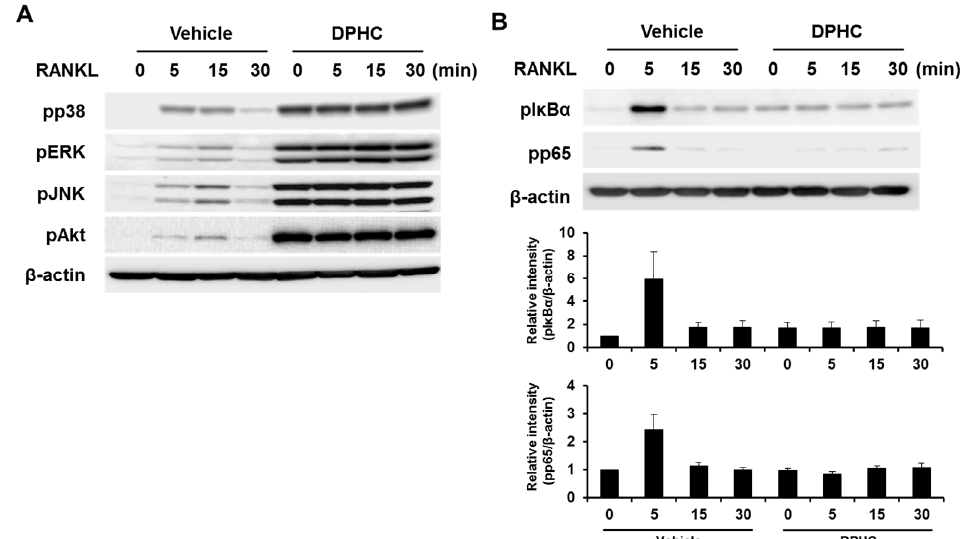
Figure 5. Effects of DPHC on the RANKL-induced signaling pathway. ( A , B ) Mouse BMMs were incubated in serum-free medium for five hours and pretreated with vehicle or DPHC (75 µ g/mL) for one hour. The cells were stimulated with RANKL (50 ng/mL) for the indicated durations, and immunoblotting was performed using specific antibodies against phosphorylated forms of p38, ERK, JNK, Akt, I κ B, and p65; β -actin was used as the loading control.